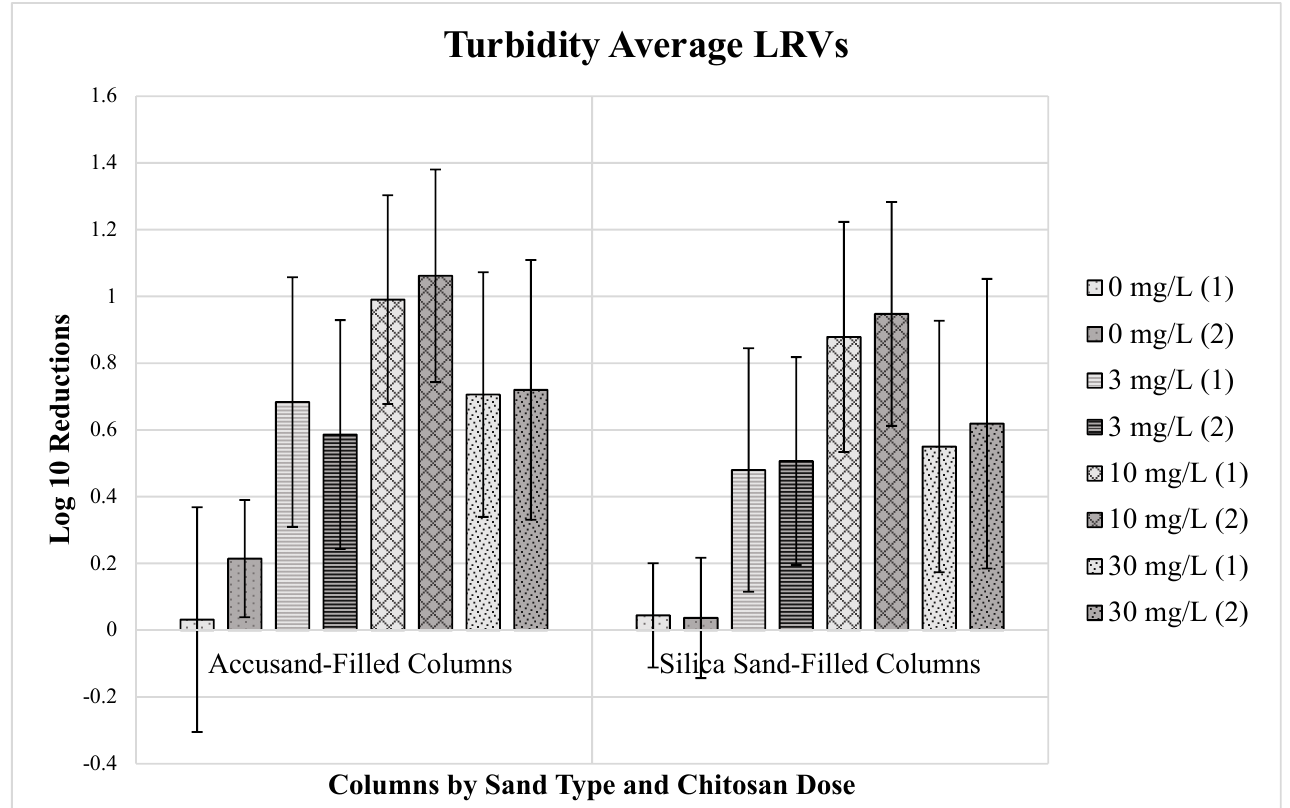
Figure 3. Average log 10 reduction values (LRVs) with standard deviation error bars for turbidity in water treated by chitosan coagulation and Accusand and silica sand column filtration, based on 17 successive samples collected throughout the 57-day experiment period.